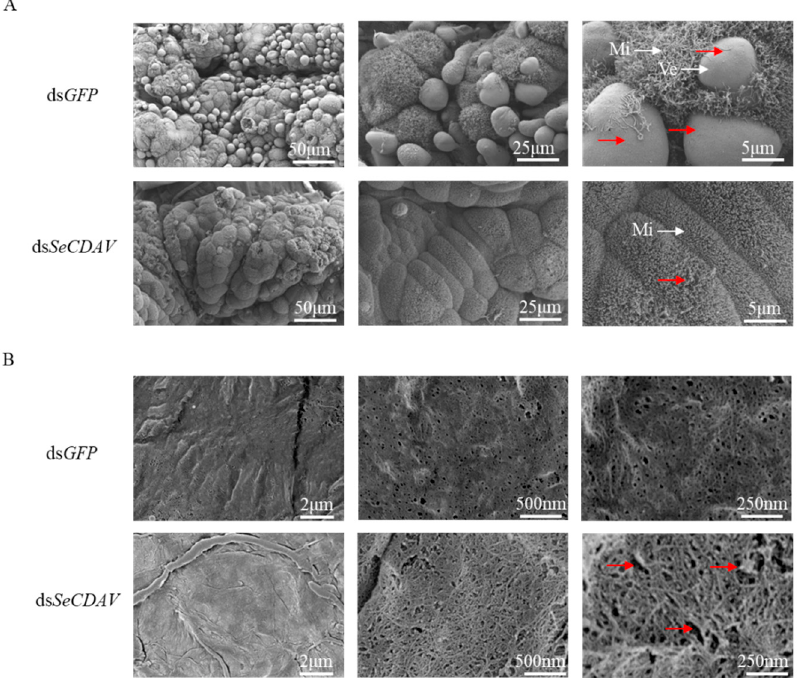
Figure 8. The ultrastructure of S. exigua larvae injected with dsRNA- SeCDAV / GFP . ( A ) Midgut ultrastructure of S. exigua larvae injected with dsRNA- SeCDAV / GFP . Red arrowheads point to vesicles. ( B ) Peripheral membrane ultrastructure of S. exigua larvae injected with dsRNA- SeCDAV / GFP . Red arrowheads point to the pores. Mi: microvilli; Ve: vesicles. The scale bars were 50 μ m, 25 μ m, 5 μ m, 2 μ m, 500 nm, and 250 nm.